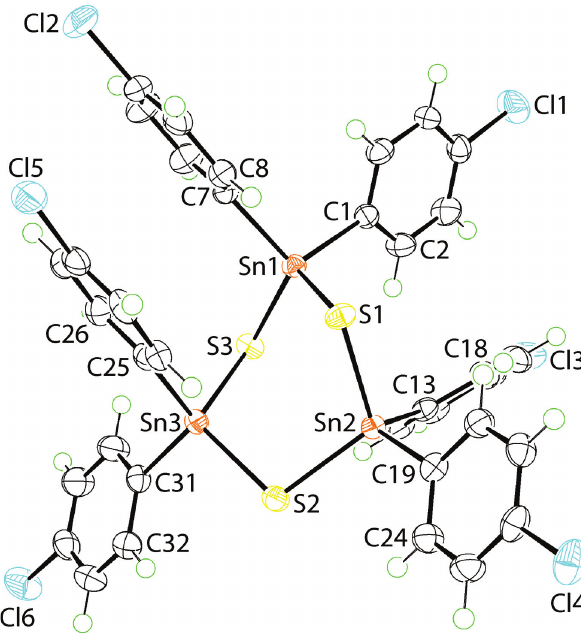
Table 2: Fractional atomic coordinates and isotropic or equivalent isotropic displacement parameters (Å 2